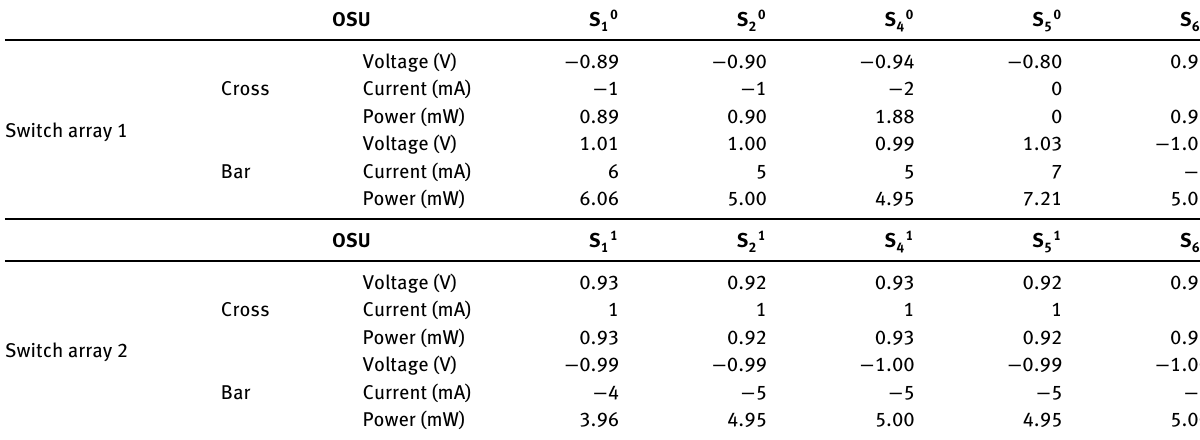
Table 2: Driving voltages and power consumptions of all the optical switch units (OSUs) under the cross and bar states.